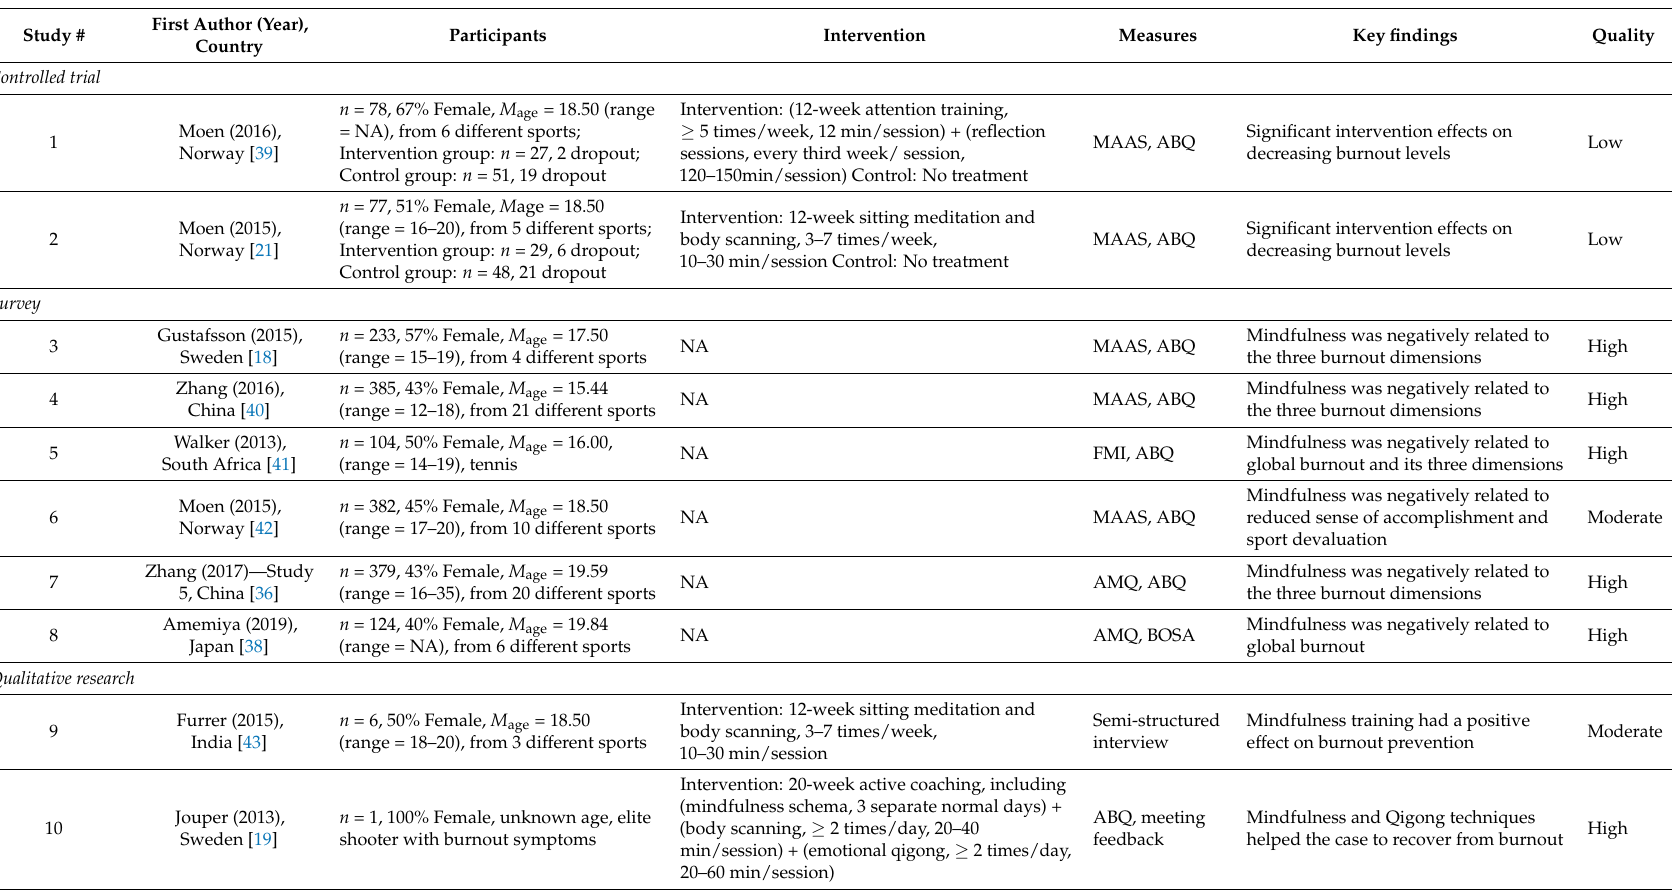
Table 1. Characteristics of the included